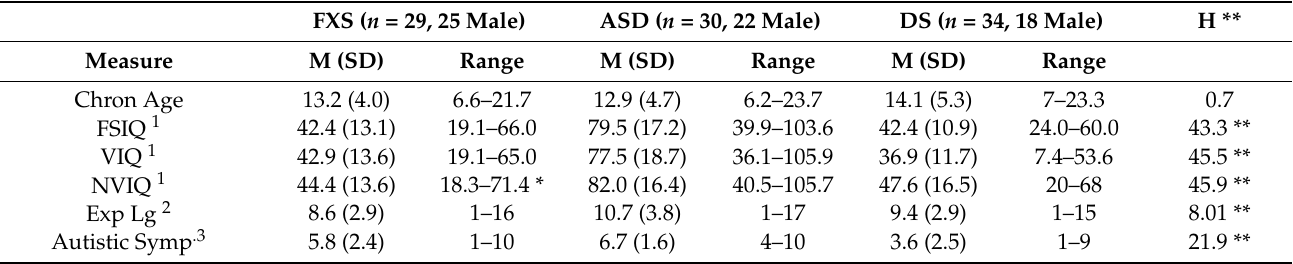
Table 1. Participant